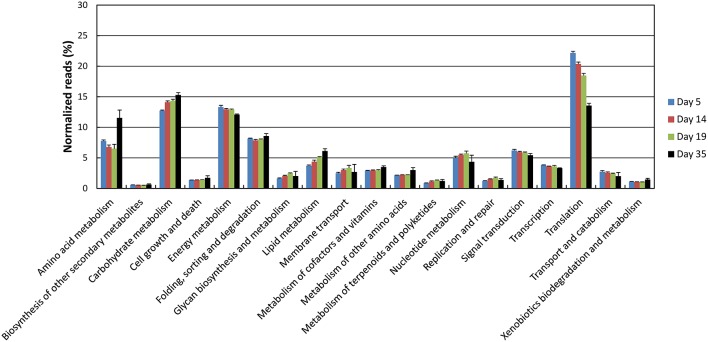
Functional classification of the cheese rind metatranscriptome. The functional classes were determined according to KEGG annotations of the CDSs. The number of reads was represented as a percentage of the total reads with KEGG assignments at each of the four sampling days, and the upper error bars represent the standard deviations (three cheese replicates).